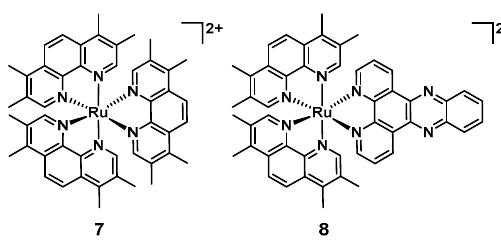
2 + ( 7 ) and [Ru(2,9-Me 4 phen) 3 ]